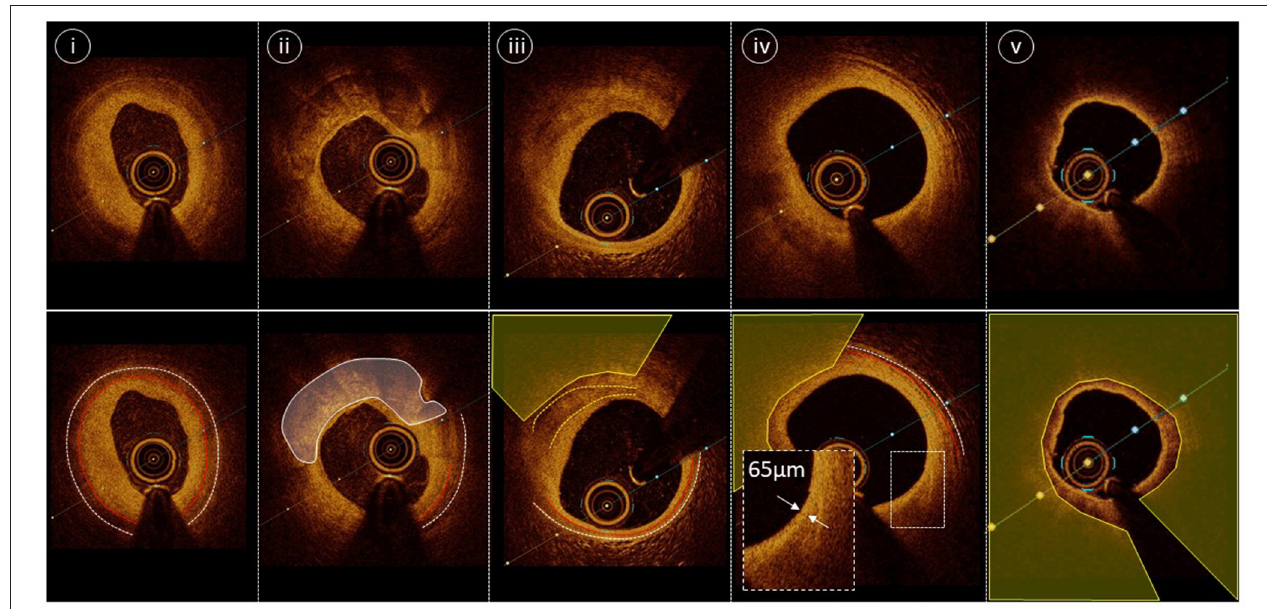
FIGURE 3 | OCT plaque characterization. Image i—represents a fibrous plaque (homogenous bright reflecting signal) with limited attenuation (loss of signal) and well demarcated EEM (white dotted line) and IEM (red dotted line). Image ii—represents fibro-calcific plaque with clearly demarcated boundaries of the calcium (white infilled area). Limited visualization of the EEM & IEM. Image iii—represents layered thick-cap fibroatheroma—layers of fibrous tissue with different reflecting signal highlighted by yellow dotted line and attenuation of signal (yellow infilled area). Image iv—represents a thin-cap fibroatheroma—the expanded area demonstrates a